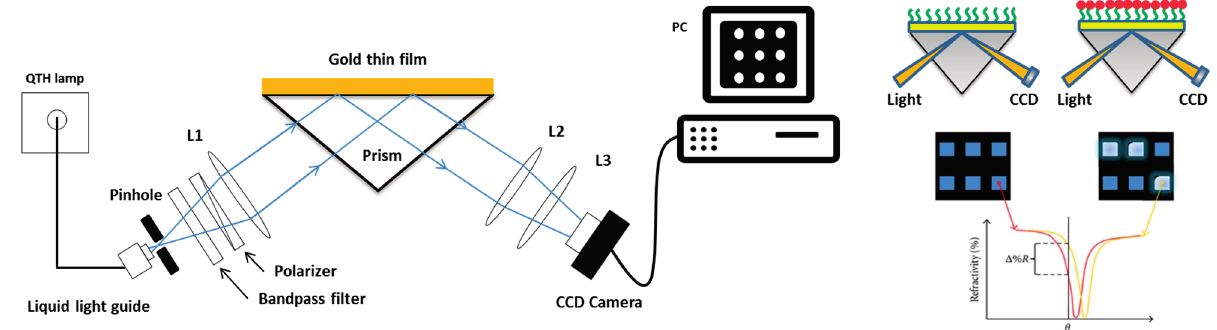
Figure 2. General principle of surface plasmon resonance imaging (SPRI). ( Left ) The instrumentation of an SPR imaging system: The light source is a quartz tungsten-halogen lamp; the light is delivered through a liquid light guide to a goniometer arm, collimated by lenses, and passed through a narrow interference filter and a polarizer. A p -polarized and monochromatic light beam is then focused directly onto a prism coupler. The reflected light from the gold surface is captured by a monochromatic CCD camera. L2, L3 are lenses positioned in front of CCD for higher quality images. The images could be digitally stored using a B/W frame grabber and further analyzed using photography software; ( Right ) The analyte-ligand interaction shifts the SPR curve towards a higher angle (red to orange). Due to the measurement confinements (fixed wavelength and angle of incidence θ ), changes in the reflectivity ( Δ %R) at a single spot of the array can be simultaneously detected. Adapted from